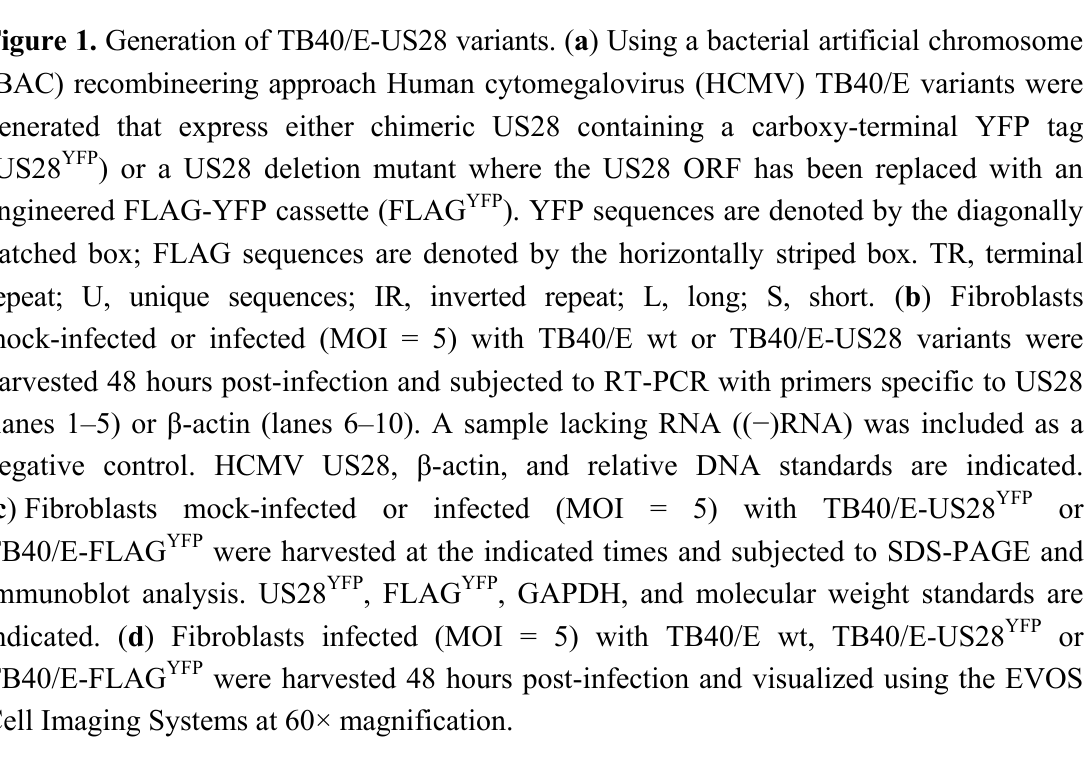
Figure 1. Generation of TB40/E-US28 variants. ( a ) Using a bacterial artificial